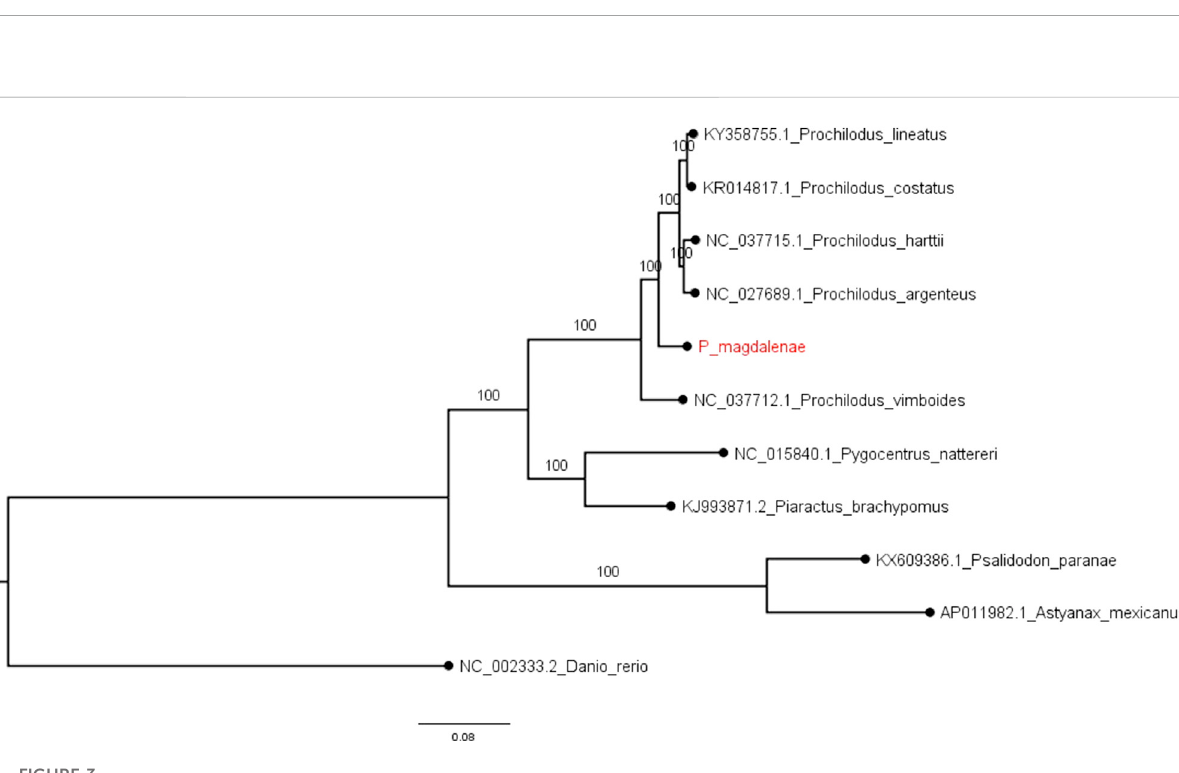
FIGURE 3 Phylogenomic tree for complete mitochondrial sequences. Examined fi shes include fi ve Prochilodus species, four characids, and zebra fi sh (as the outgroup). Node support (aLRT) values are indicated at the nodes. The tree was rooted on midpoint and branch lengths are drawn to scale with the bar at the bottom indicating nucleotide substitutions per site. P. magdalenae is highlighted in